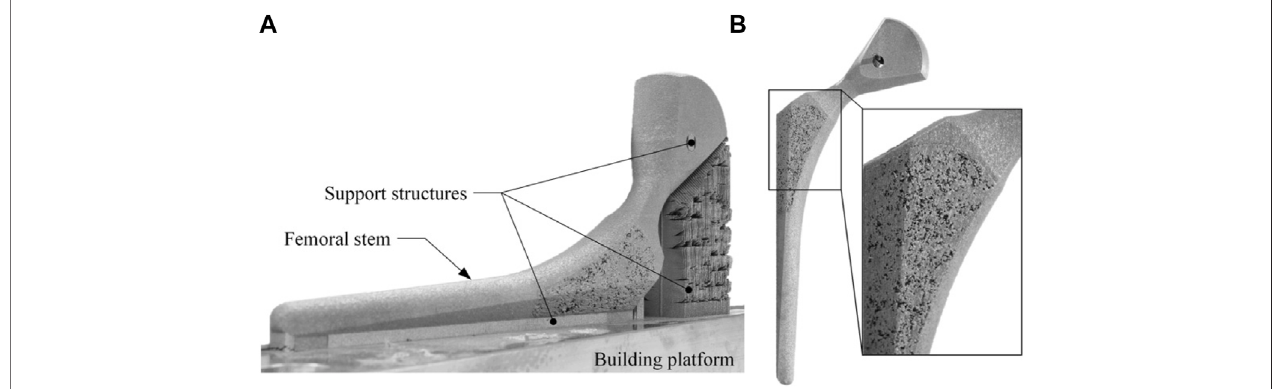
FIGURE4 | Femoral stem withstochastic porousstructure: (A) porous femoralstem immediately after selective lasermeltingprocessing. (B) porous femoralstem after post-treatment, including residual powder removal, separation from the manufacturing platform, and micro-blasting with aluminum oxide (Simoneau et al., 2017).